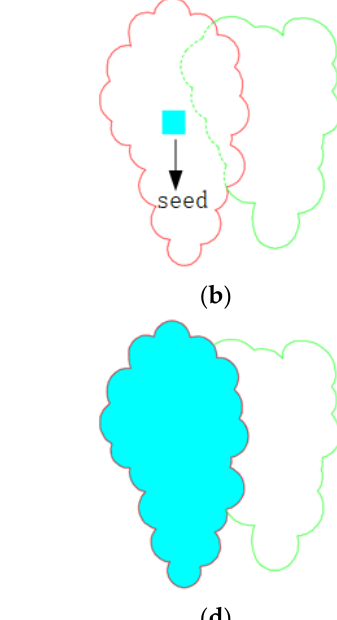
Figure 3. The steps of the proposed depth region method. ( a ) The overlapping grape clusters, ( b ) the seed point, ( c ) region growing, and ( d ) the extracted front cluster.